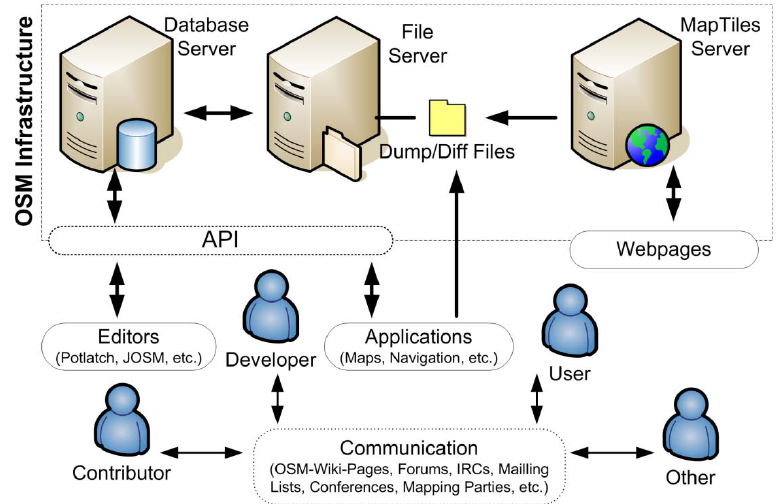
Figure 1. OpenStreetMap (OSM) project digital infrastructure and its community. IRC, Internet relay